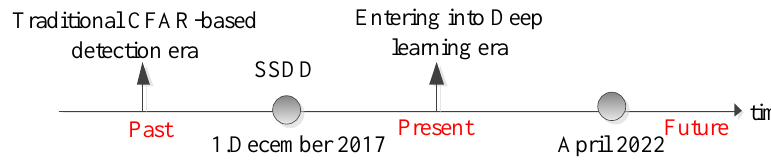
Figure 3. The time divisions of past, present and future.